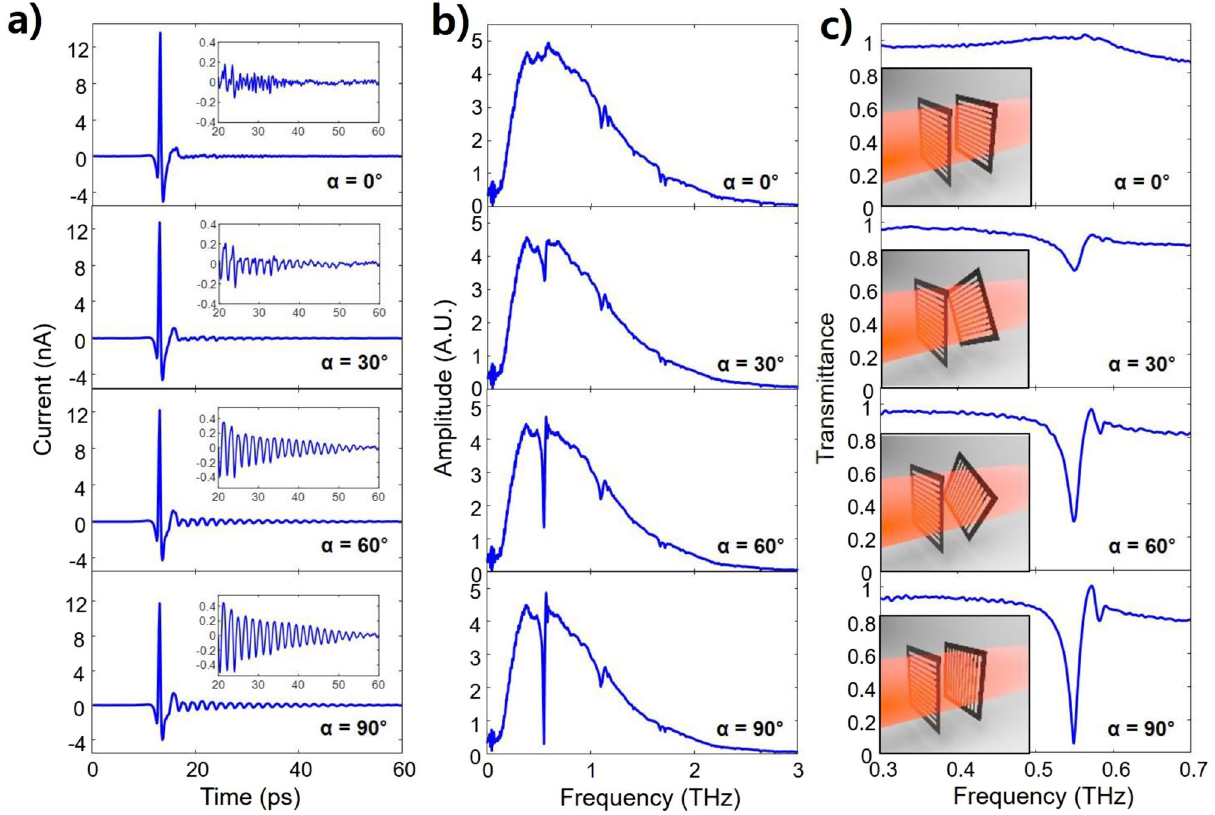
Figure 2. When the angle of the wave polarization and the first grating film is fixed at 0° (Φ = 0), ( a ) Measured THz pulses for different rotation angles of α = 0°, α = 30°, α = 60°, and α = 90°. The inset figures show an expanded window of the oscillations due to the GMR effect after the main THz pulse. ( b ) Corresponding amplitude spectra of the measured THz pulses. ( c ) Corresponding transmittance of the measured amplitude spectra. The inset figures show schematics of the notch filter with two individual monolayer grating films with different